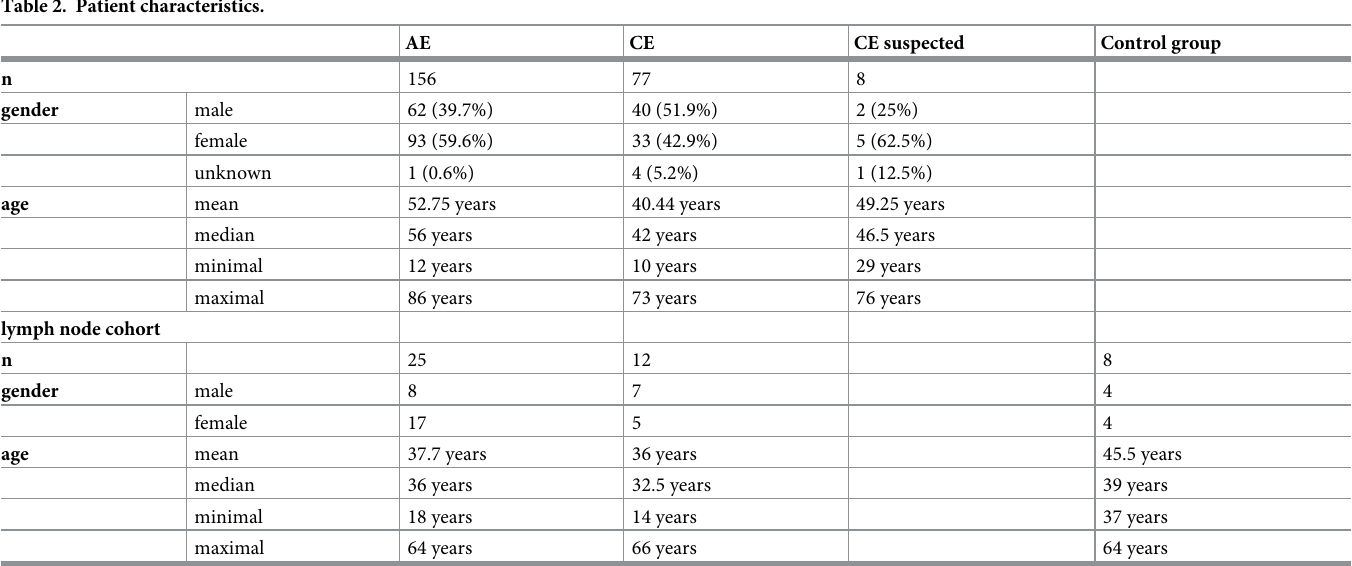
Table 2. Patient